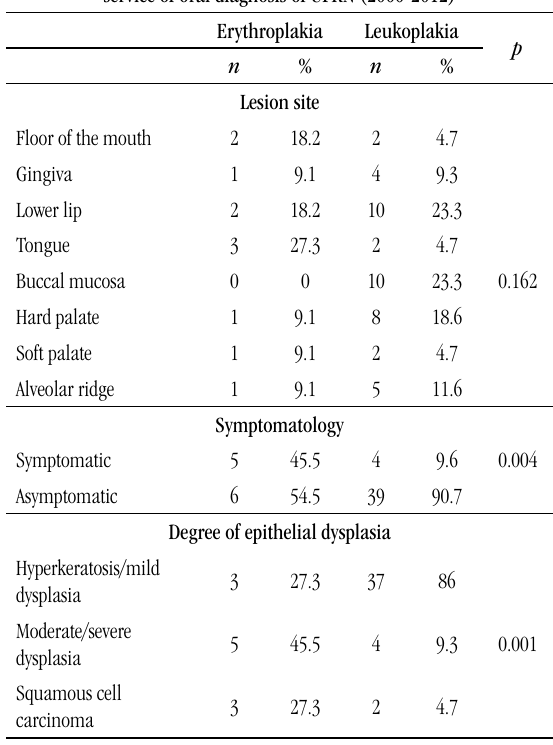
tABLE 2 – Clinical and histopathological features of oral erythroplakia and leukoplakia cases at the service of oral diagnosis of UFRN